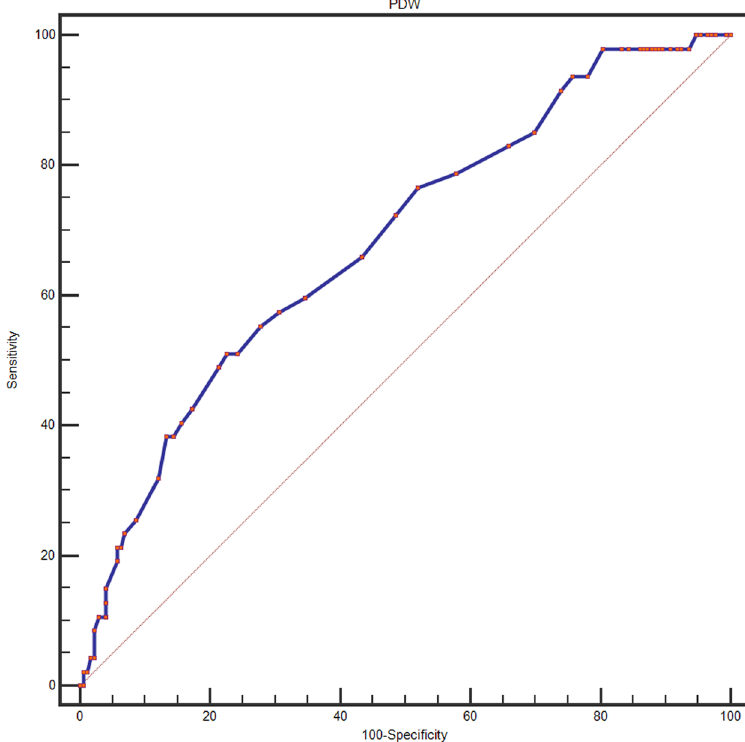
Figure 1. Optimized cut-off was determined for PDW using standard ROC curve